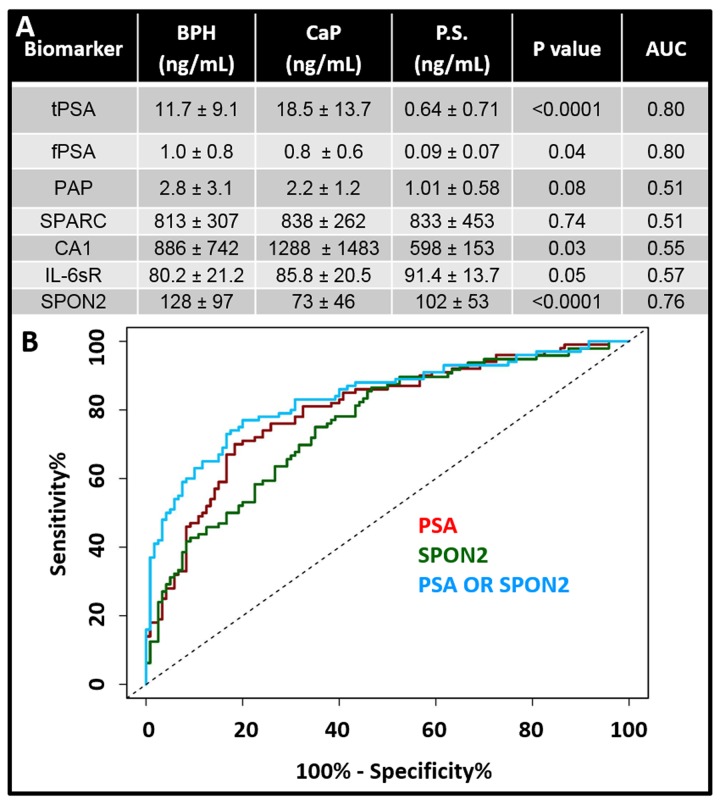
Clinical Data Analysis.A) Mean values with standard deviation for the seven biomarkers with BPH, CaP, and post-surgery [39] samples. Units are ng/mL. The p value reported here is the significance between the BPH and CaP samples. AUC values are also given and report discrimination between CaP and BPH. Lower panel presents ROC curves for PSA, SPON2, and PSA OR SPON2. The OR operator increases the AUC to 0.84 from 0.80 for PSA alone.